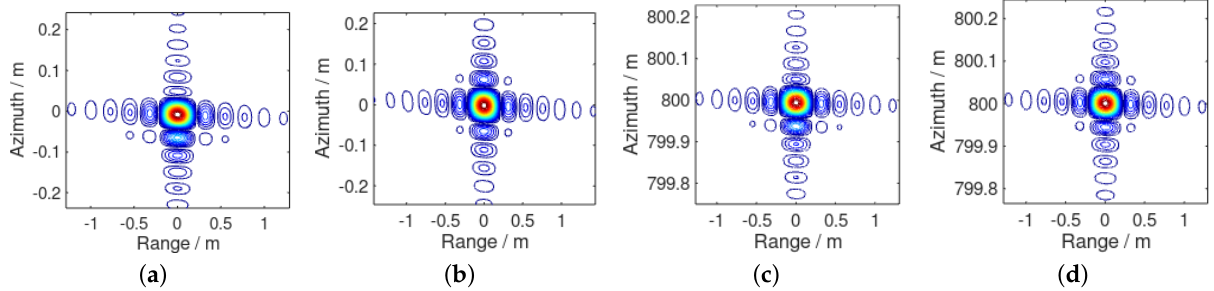
Figure 10. Comparison results of signal s 5 with the proposed/traditional sub-aperture MoCo. ( a ) Imaging result of Point A with traditional sub-aperture MoCo. ( b ) Point A with proposed sub-aperture MoCo. ( c ) Point D with traditional sub-aperture MoCo. ( d ) Point D with proposed sub-aperture